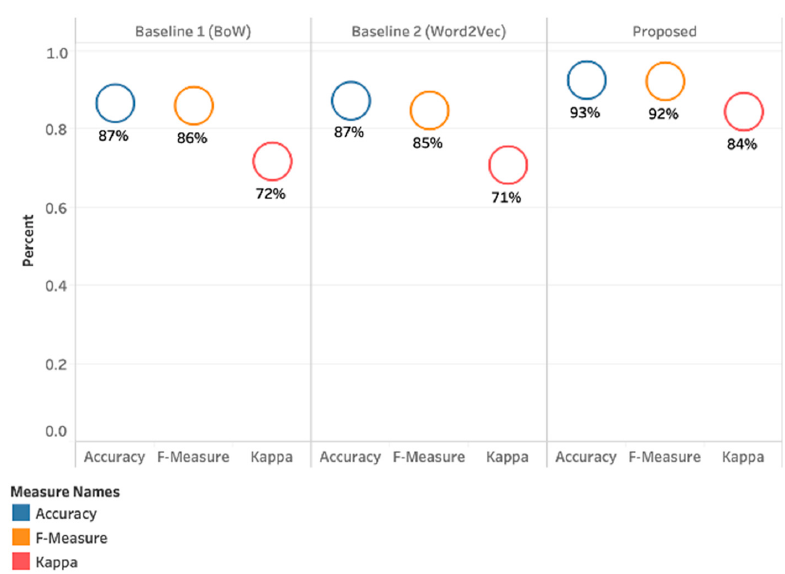
Figure 6. Comparison of baseline approach with the proposed approach.